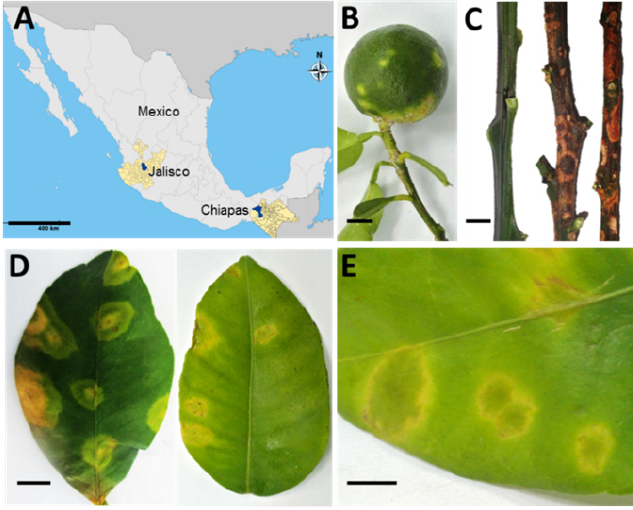
Figure 1. Symptoms of leprosis in bitter orange in Mexico. ( A ) Plant tissue was collected in the urban zones of Guadalajara, Jalisco, and Tecpatán and Ocozocuautla, Chiapas; shown in blue in the map. ( B ) Typical symptoms found in bitter orange ( C. × aurantium ) fruit, including chlorotic spots, which, in later stages of the disease, appear brown. ( C ) A healthy stem is shown on the left; a corking and brownish stem can be observed in infected tissue. ( D ) Similar chlorotic spots were observed in leaves of infected C. × aurantium , which are distributed asymmetrically on the leaf surface. Leaves also display rugosity and asymmetric development. ( E ) Close-up of an infected